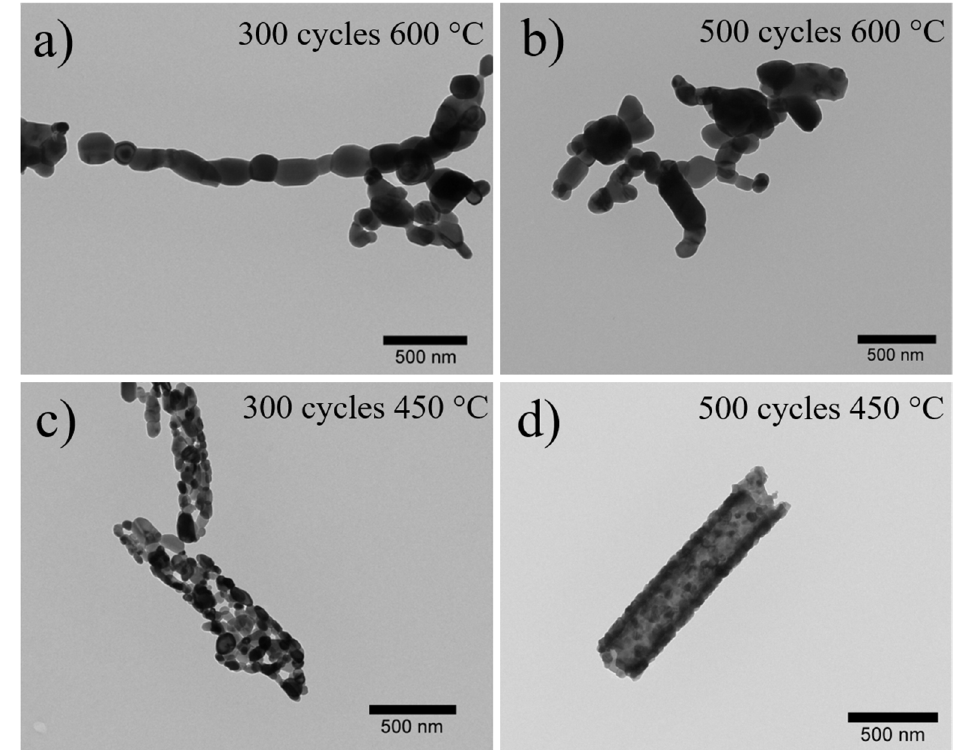
Figure 1. TEM images of ZnO nanostructures obtained by applying different conditions of number of cycles and temperature of calcination: ( a ) 300 cycles and 600 °C; ( b ) 500 cycles and 600 °C; ( c ) 300 cycles; and ( d ) 500 cycles and 450 °C.